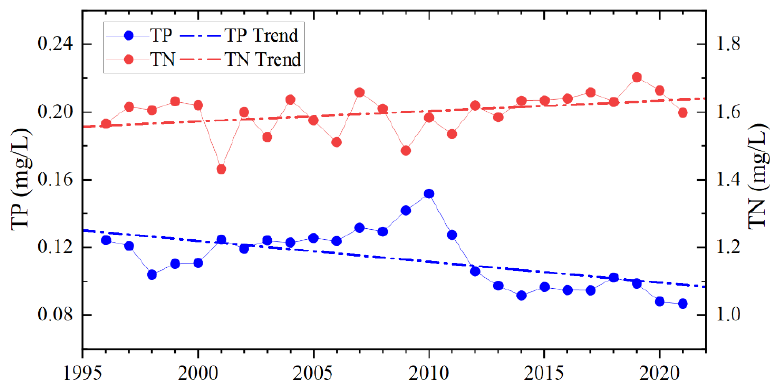
Figure 4. Changes in water quality parameters in Dongting Lake from 1996 to 2021.